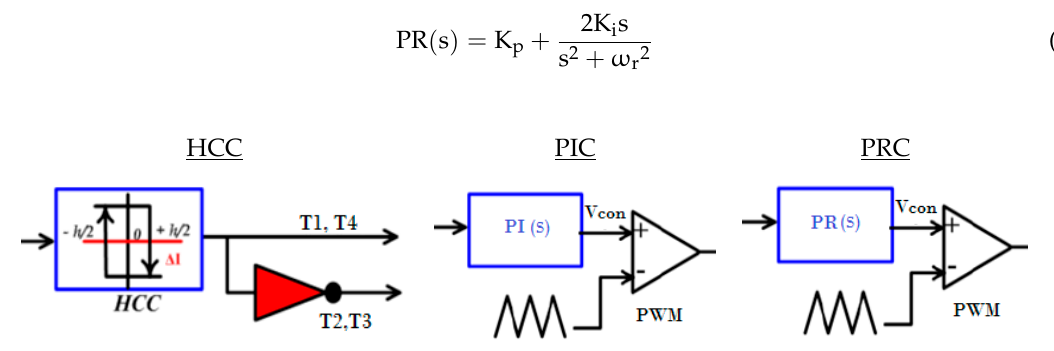
Figure 10. Block diagram of the V2G control strategies.